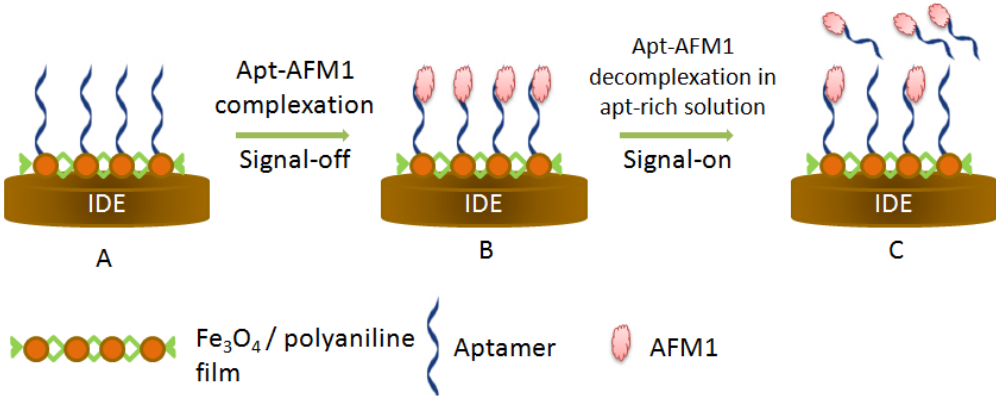
Figure 6. Principle of label-free aptasensor of AFM1 based on Fe 3 O 4 /polyaniline film polymerization on interdigitated electrode. (A) Functionalization of the surface with AFM1 aptamer; (B)